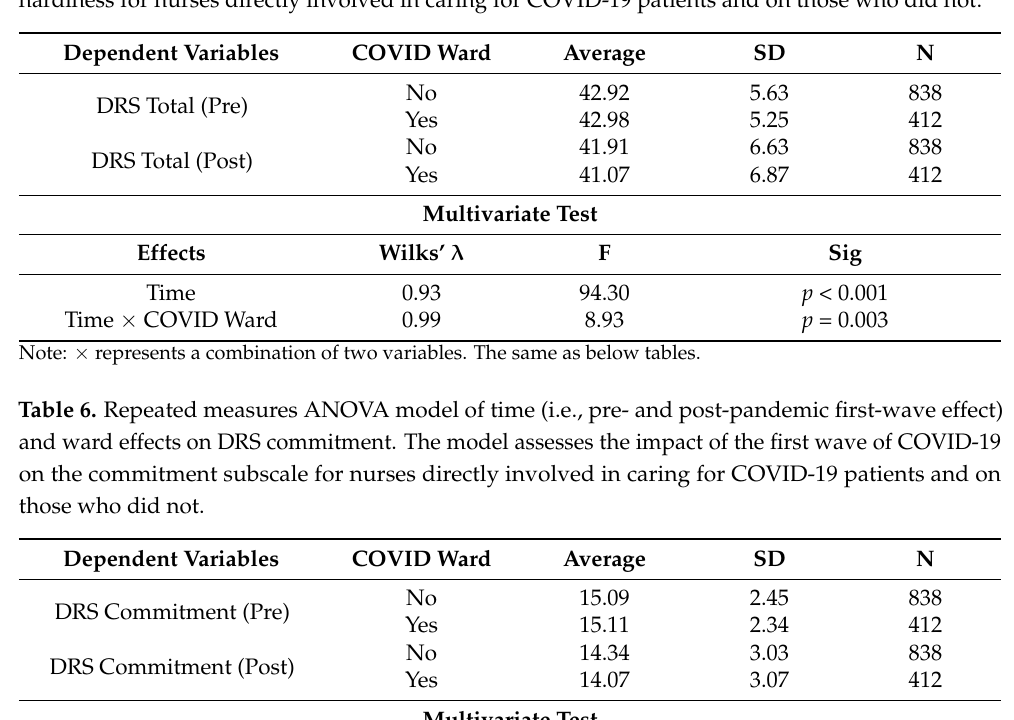
Table 5. Repeated measures ANOVA model of time (i.e., pre- and post-pandemic first-wave effect) and ward effects on DRS total. The model assesses the impact of the first wave of COVID-19 on total hardiness for nurses directly involved in caring for COVID-19 patients and on those who did not.